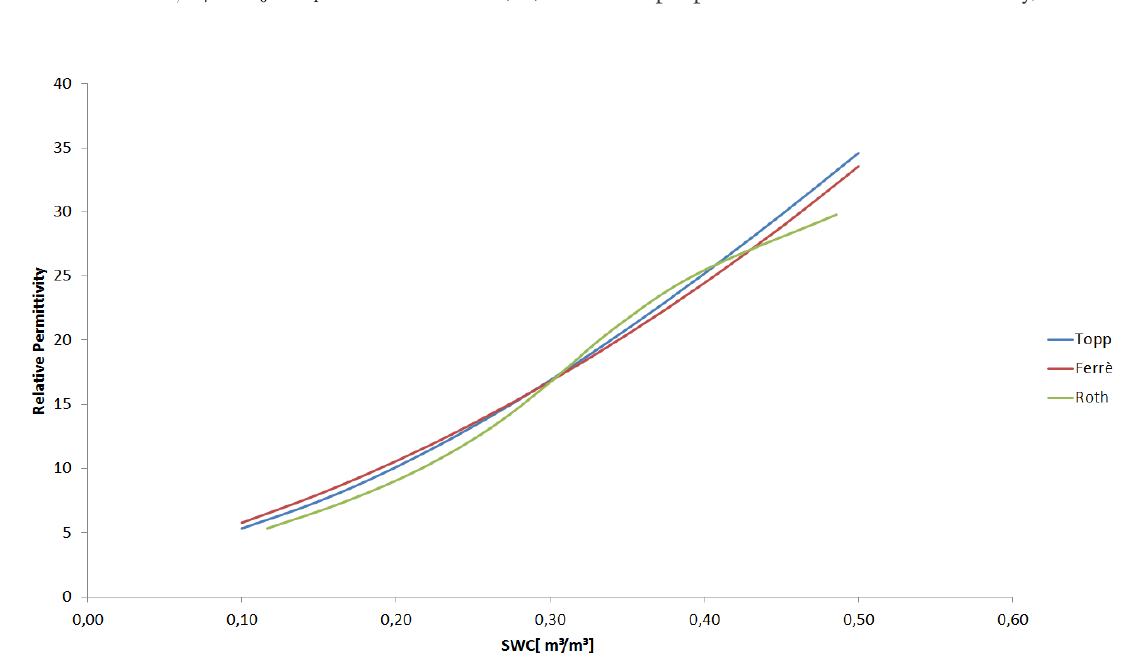
Figure 3. Empirical relations